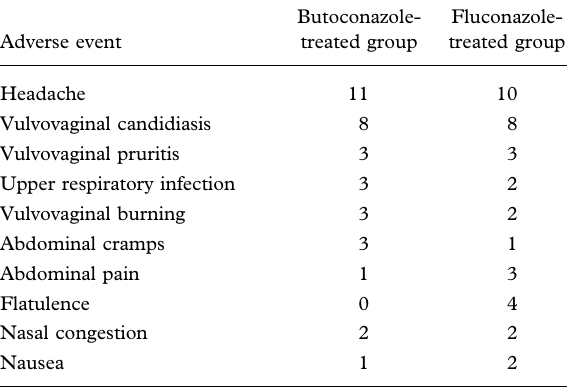
Table II. Most common patient-reported adverse events whether or not drug-related.